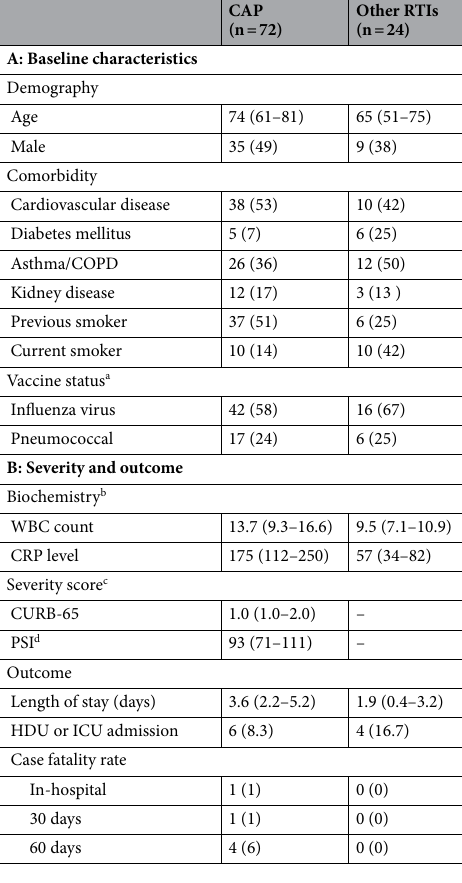
Table 1. Characteristics of the study cohort of n = 96 patients with community acquired respiratory tract infections. Data shown as count (%) or median (IQR). CAP, community acquired pneumonia; RTI, respiratory tract infection; COPD, chronic obstructive pulmonary disease; WBC, white blood cells; CRP, C-reactive protein; CURB-65, confusion, urea, respiratory rate, blood pressure, age ≥ 65 years; PSI, pneumonia severity index; HDU, high dependency unit; ICU, intensive care unit; IQR, interquartile range. a Vaccinated for influenza virus within the last year; for Streptococcus pneumoniae within the last 5 years. b Highest value during hospital stay. c Only validated for CAP patients. d Missing in five patients with CAP.